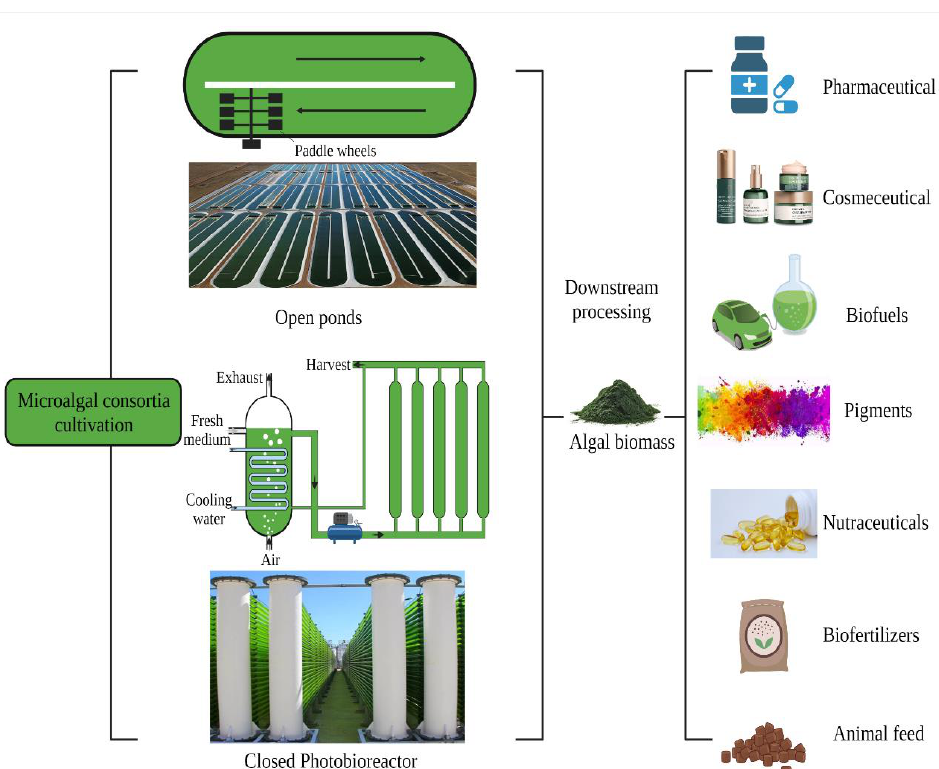
Figure 4. Microalgal consortia cultivation and its potential uses in various industries. Various culti- vation systems for microalgal consortia (left) to produce biomass for diverse bioproducts, including pharmaceuticals, cosmeceuticals, biofuels, pigments, nutraceuticals, biofertilizers, and animal feed. Table 7. Microalgal consortia in bioproduction. Microalgal biomass contains large quantities of nitrogen, and significantly, many cyanobacteria can fix atmospheric nitrogen. Therefore, such microalgal biomass could serve as biofertilizer after a series of treatments. For example, the wastewater-grown microalgal consortia biomass, produced by the unicellular microalgae consortia MC1 ( Chlorella , Scenedesmus , Chlorococcum , Chroococcus ) and the filamentous microalgae MC2 ( Phormidium , Anabaena , Westiellopsis , Fischerella , Spirogyra ), was used as a biofertilizer. Both consortia enhanced the wheat crop ( Triticum aestivum L. HD2967) productivity and yield, compared with the recommended dose of NPK fertilizers [176]. Similar results were obtained in rice using the consortia of Anabaena oscillarioides CR3, Brevundimonas diminuta PR7, and Ochrobactrum anthropi PR10 [178]. More recently, a study has shown that the application of co-inoculants Spirulina platensis and Pseudomonas stutzeri enhanced the growth and productivity of onions (Allium cepa L.) [179]. Sears and Prithiviraj reported cyanobacteria-based consortial inoculants named TerraDerm for fertilizing desert soil [181]. These examples provide promising, low-cost, and sustainable biofertilizers for